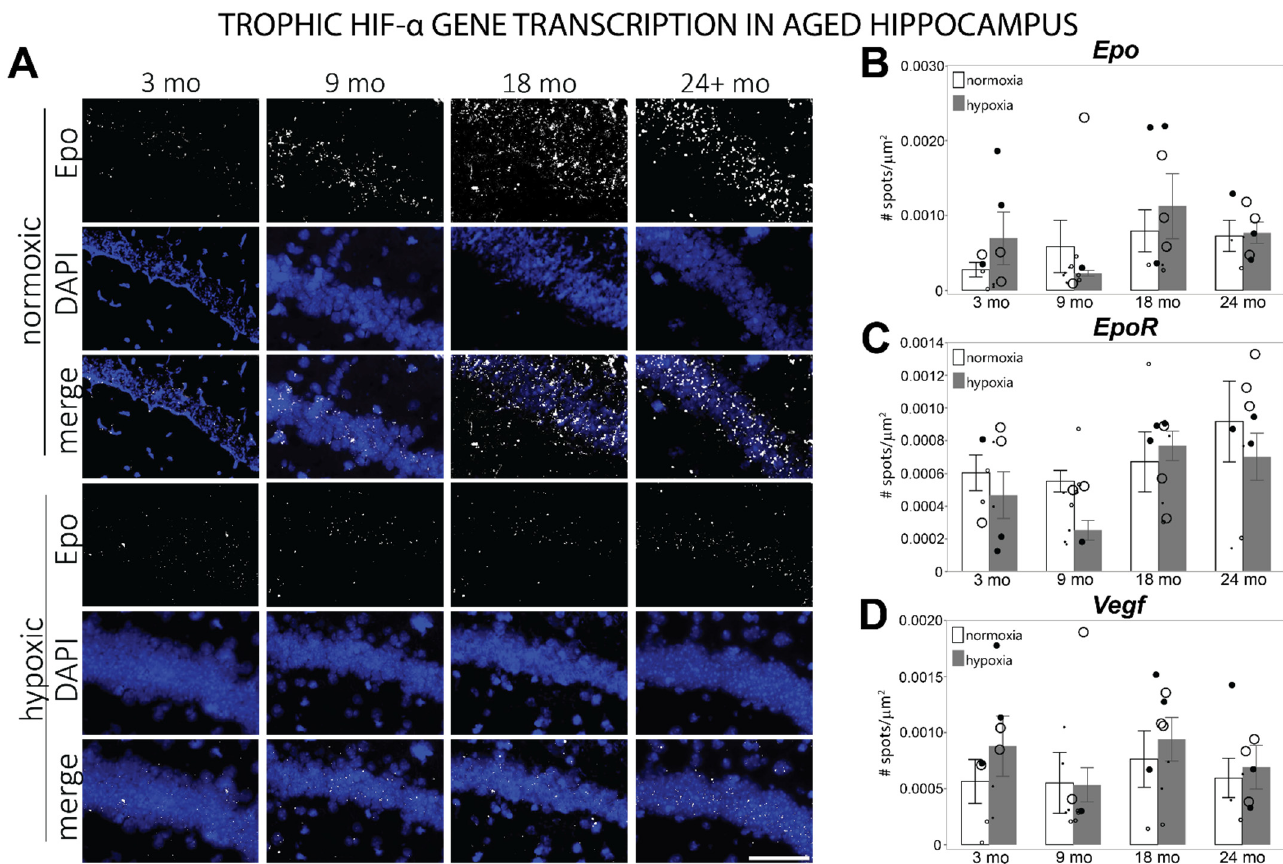
Figure 5. mRNA levels of trophic genes transcribed by HIF- α in the hippocampus of different aged mice exposed to room air or hypoxia. ( A ) Representative images of Epo mRNA labeled by fISH in the CA1 region of the hippocampus. ( B ) Epo mRNA levels counted in the hippocampus of 3 mo, 9 mo, 18 mo, and 24 mo mice exposed to room air or hypoxia. ( C ) EpoR mRNA levels counted in the hippocampus of 3 mo, 9 mo, 18 mo, and 24 mo mice exposed to room air or hypoxia. ( D ) Vegf mRNA levels counted in the hippocampus of 3 mo, 9 mo, 18 mo, and 24 mo mice exposed to room air or hypoxia. Results are reported as the mean number of spots counted per area ( μ m 2 ). Scale bar = 100 um; small dots = female mice; large dots = male mice; normoxic = open circles); 3% oxygen for 3 h = filled circles.